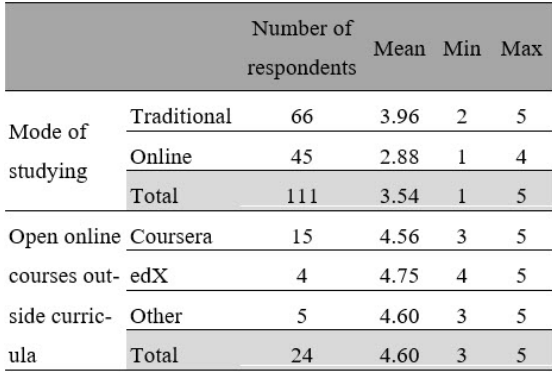
Table 2. Student satisfaction with